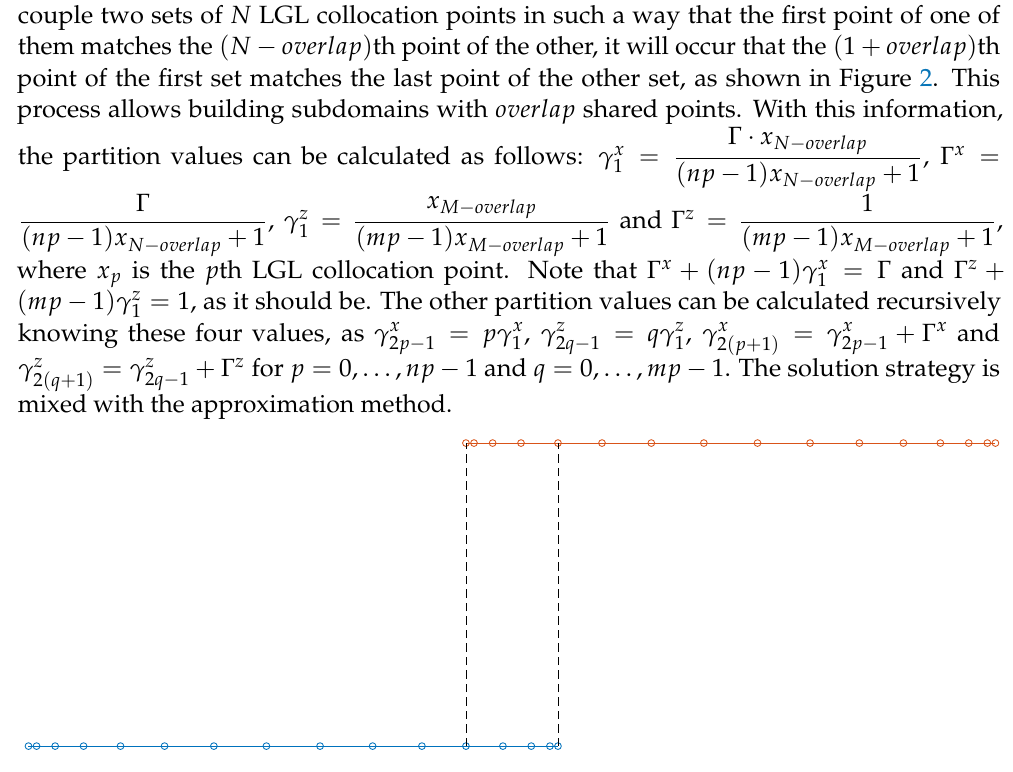
Figure 2. Example of overlap between Legendre collocation nodes in adjacent domains; N = 16, overlap =